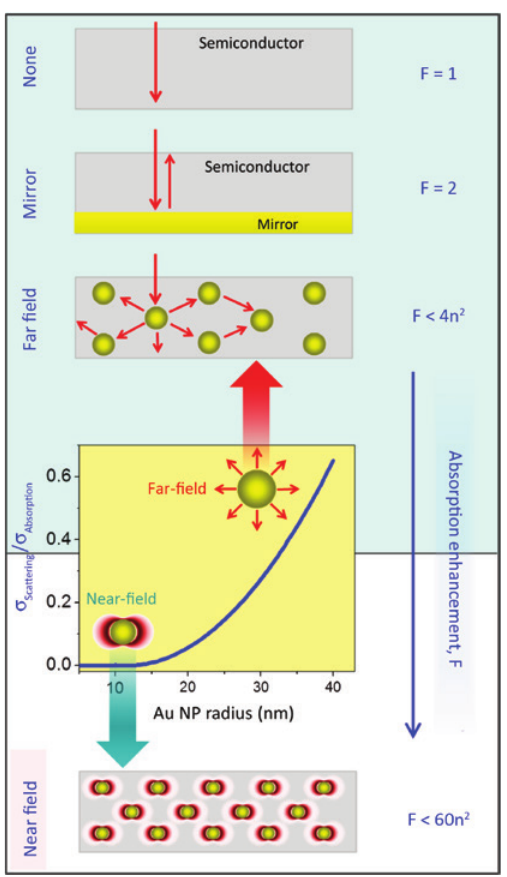
Figure 2: Comparison of absorption enhancement strategies for PV devices.